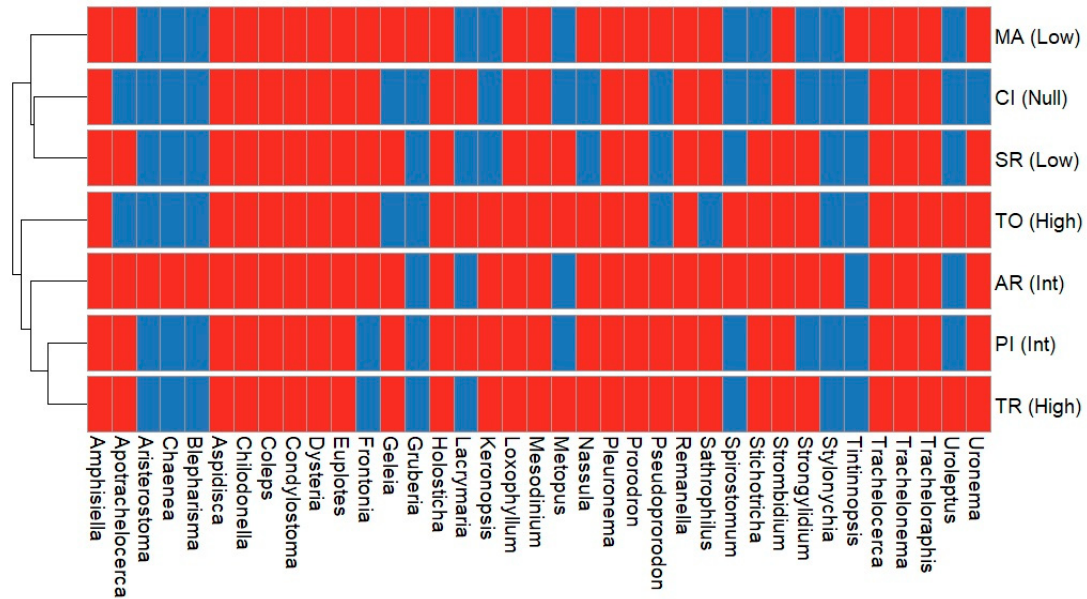
Figure 3. Ciliophora species richness for seven beaches from northern Rio Grande do Sul state (RS), Brazil, based on data collected during the study period (June 2016 to July 2017). Mean richness values are indicated with an ‘X’ inside boxplots. (AR: Arroio do Sal (intermediate degree of urbanization), CI: Cidreira (null degree of urbanization), MA: Magistério (low degree of urbanization), PI: Pinhal (intermediate), SR: Santa Rita (low degree of urbanization), TO: Torres (high degree of urbanization), TR: Tramandaí (high degree of urbanization)).